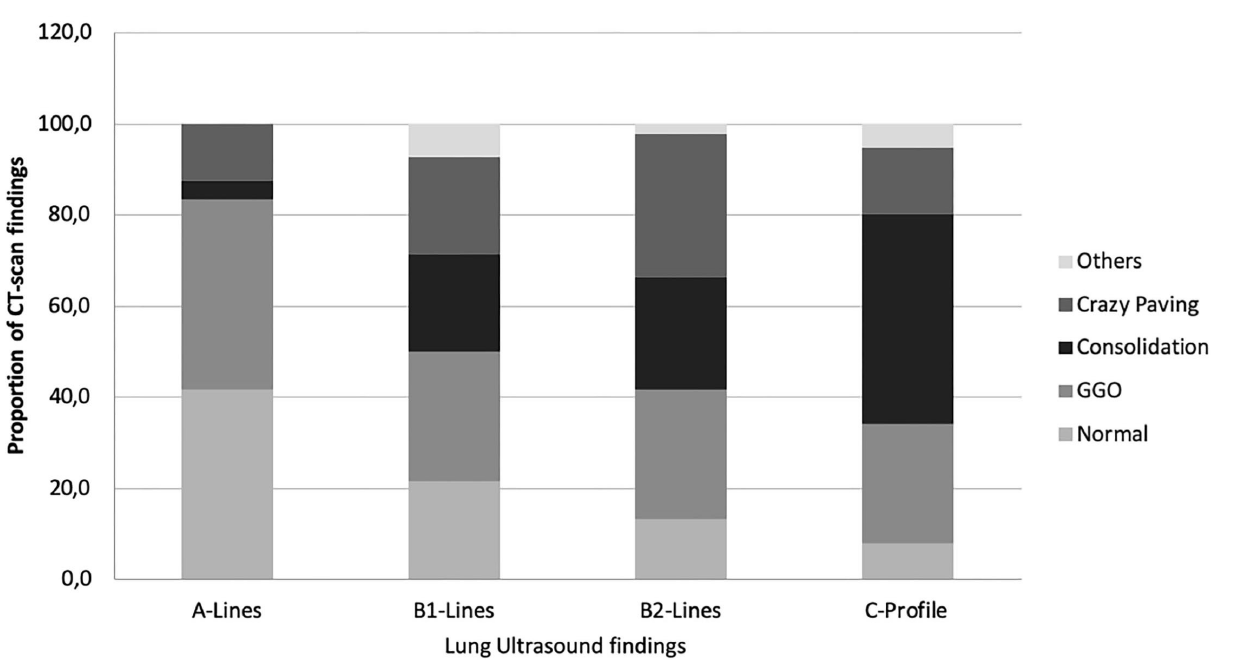
Frontiers in Medicine |